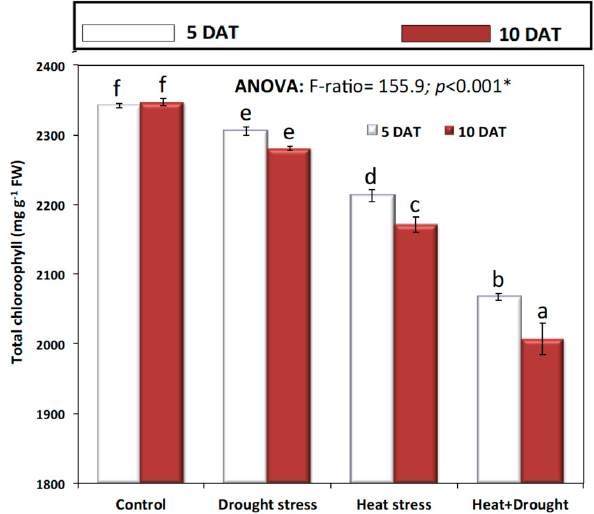
Figure 4. Effect of drought, heat, and interaction between drought and heat stresses on total chlorophyll contents of A. sieberi alba . Data expressed as mean of triplicates, error bars represent standard error for means. Means marked with different letters are significantly different according to ANOVA and DMRTs at p < 0.05.